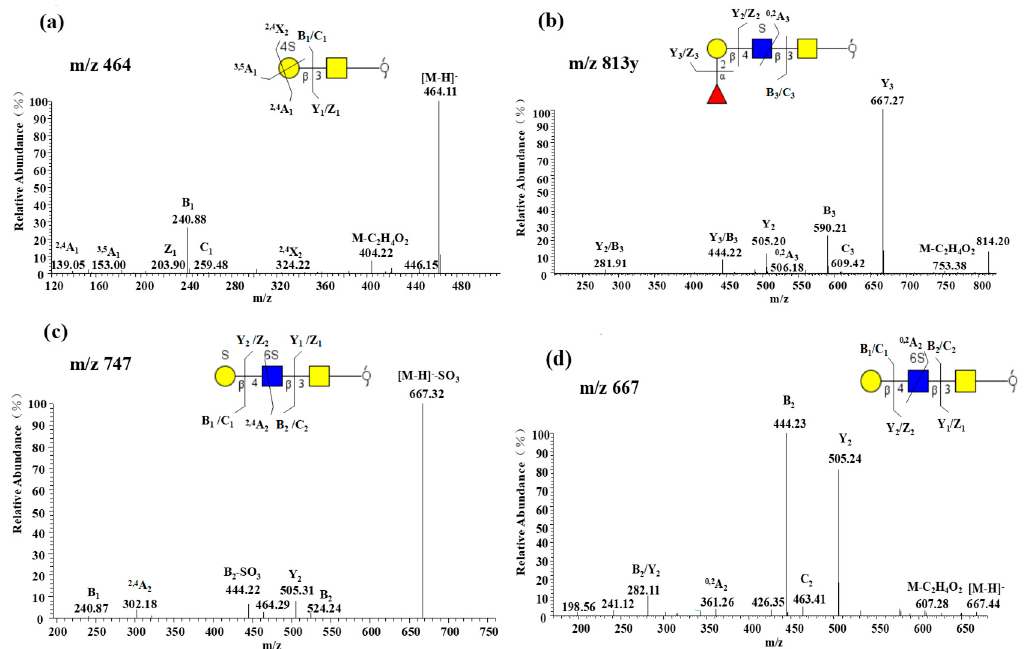
Figure 4. MS/MS spectra of different sulfated oligosaccharides recorded in the negative ion mode: ( a ) (SO 3 − )4Gal β 1-3GalNAc-ol; ( b ) Fuc α 1-2Gal β 1-4(SO 3 − )GlcNAc β 1-3GalNAc-ol; ( c ) (SO 3 − )Gal β 1-4 (SO 3 − )6GlcNAc β 1-3GalNAc-ol; ( d ) Gal β 1-4(SO 3 − )6GlcNAc β 1-3GalNAc-ol.